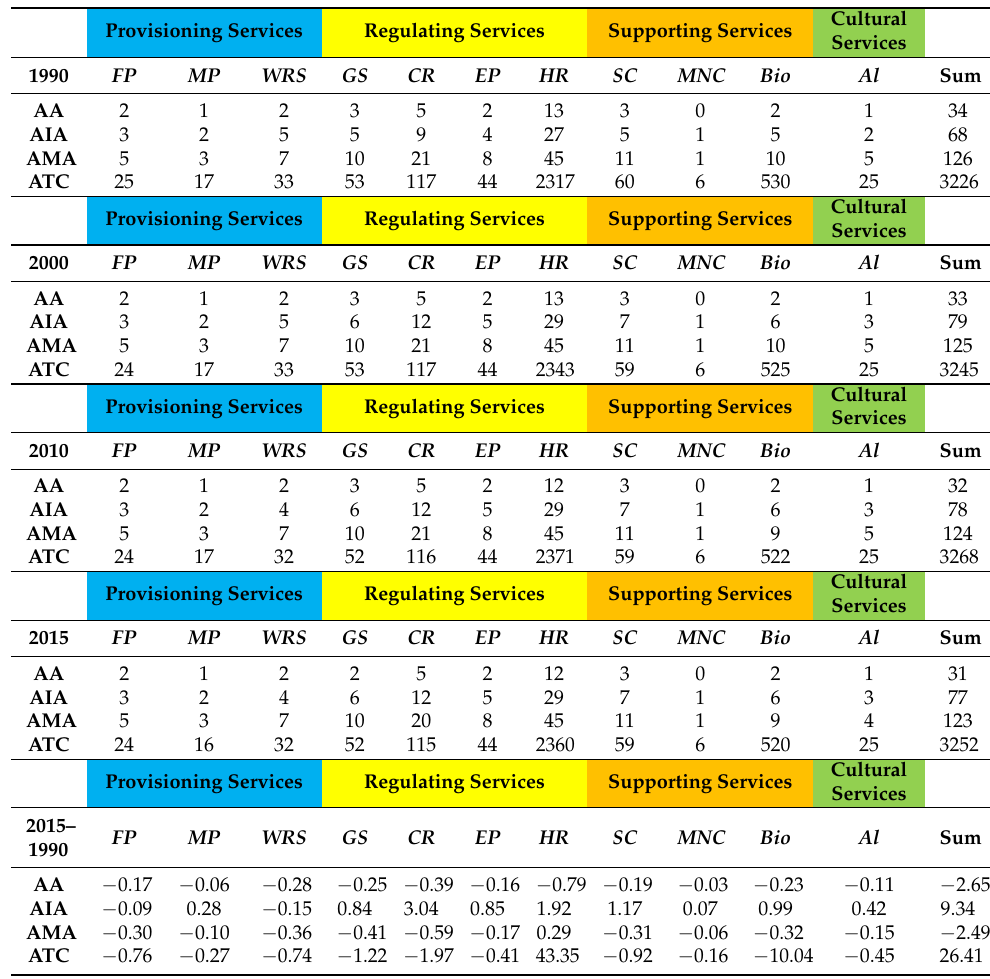
Table 4. ESV of AEZs (in million RMB; FP, food production; MP, material production; water resources supply, WRS; gas regulation, GS; CR, climate regulation; EP, environmental purification; HR, hydro- logical regulation; SC, soil conservation; MNC, maintenance of nutrient cycle; Bio, biodiversity; AL, aesthetic landscape; PS, provisioning services; RS, regulating services; SS, supporting services; CS, cultural